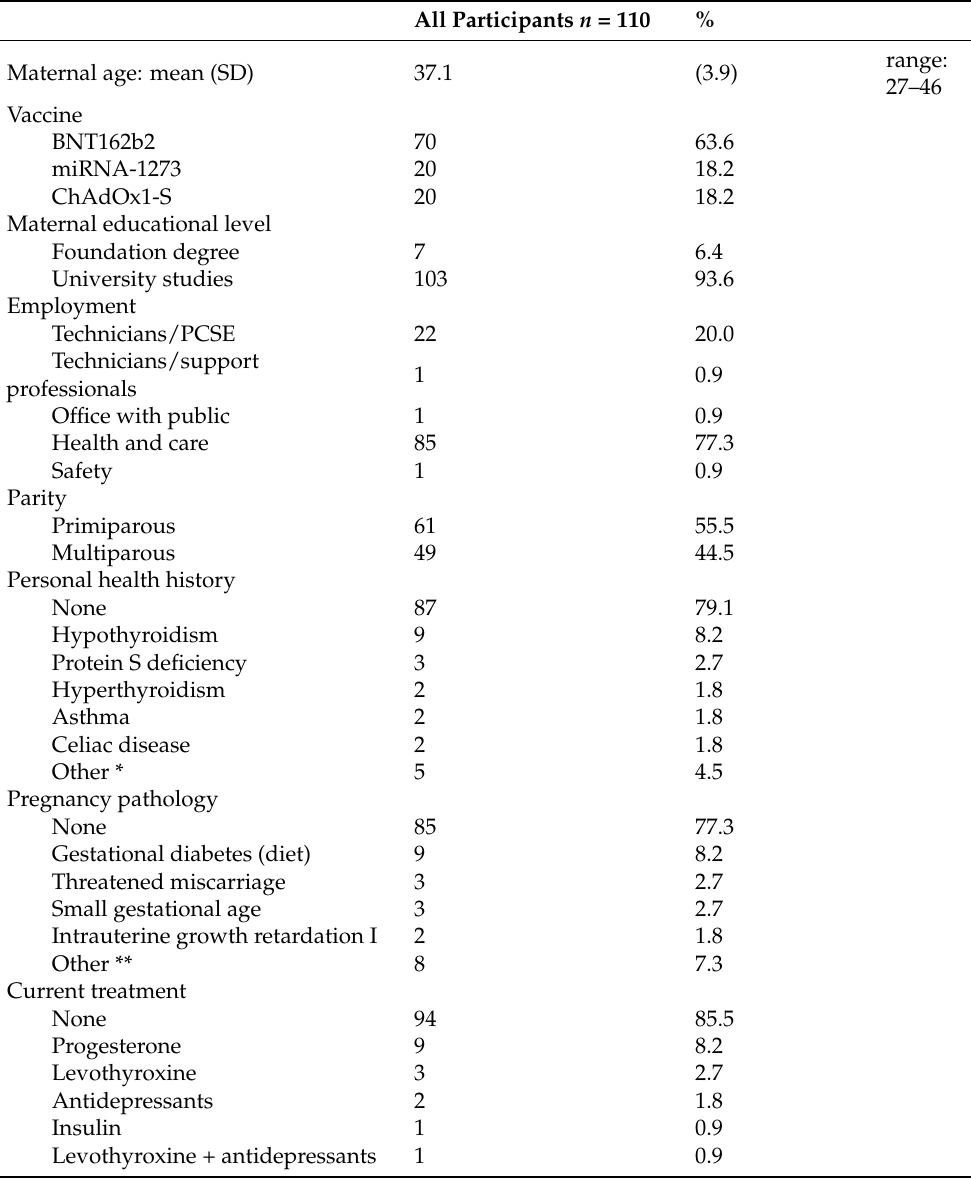
Table 1. Descriptive analysis of the breastfeeding mothers included during the study period